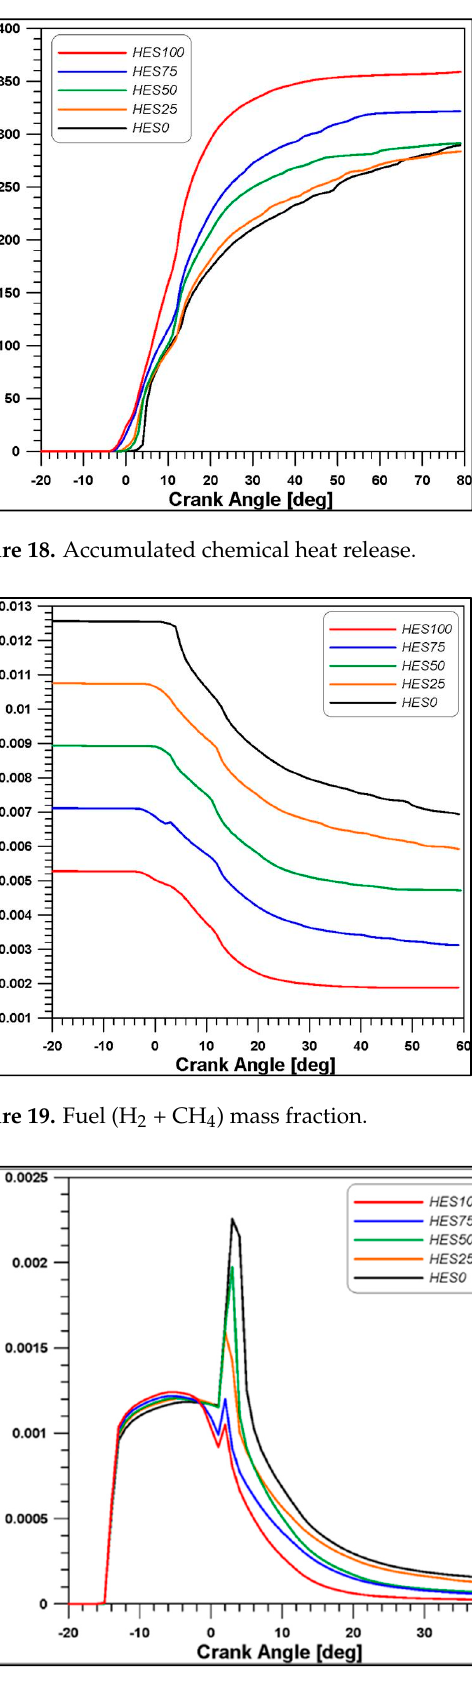
Figure 17. Rate of heat release.